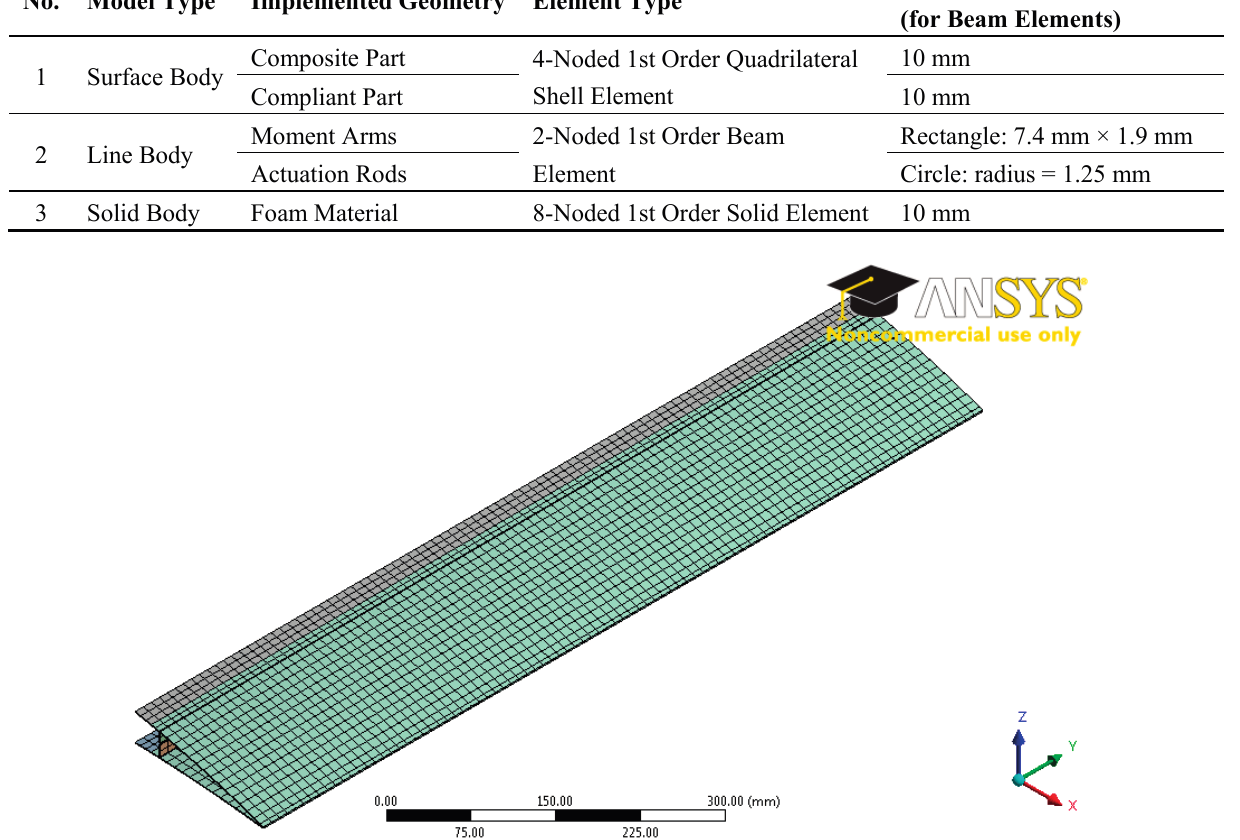
Figure 13. Isometric view of generated mesh for open cell design.